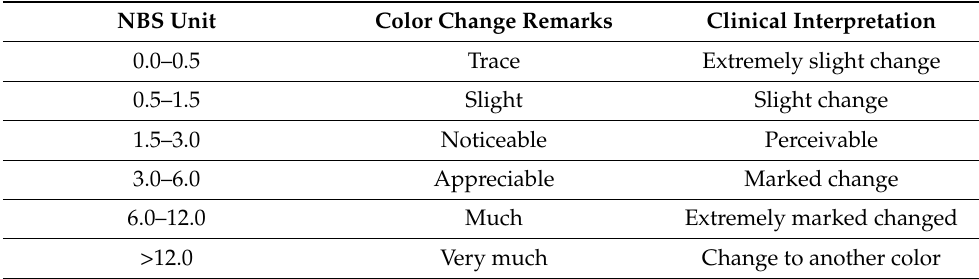
Table 2. NBS interpretation of color